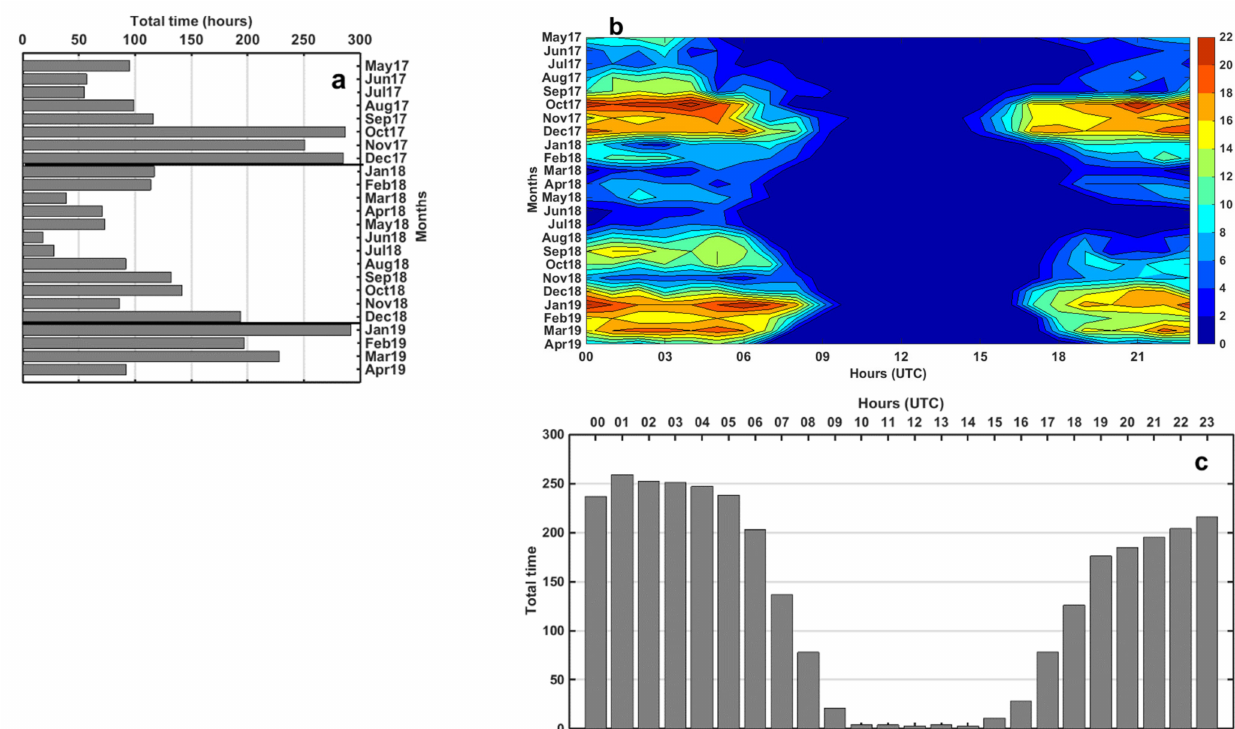
Figure 11. Land breeze occurrences in hours representing monthly ( a ), daily cycle per month ( b ) and daily cycle for all period ( c ). Grey horizontal lines in panel ( a ) separate the years 2017, 2018 and